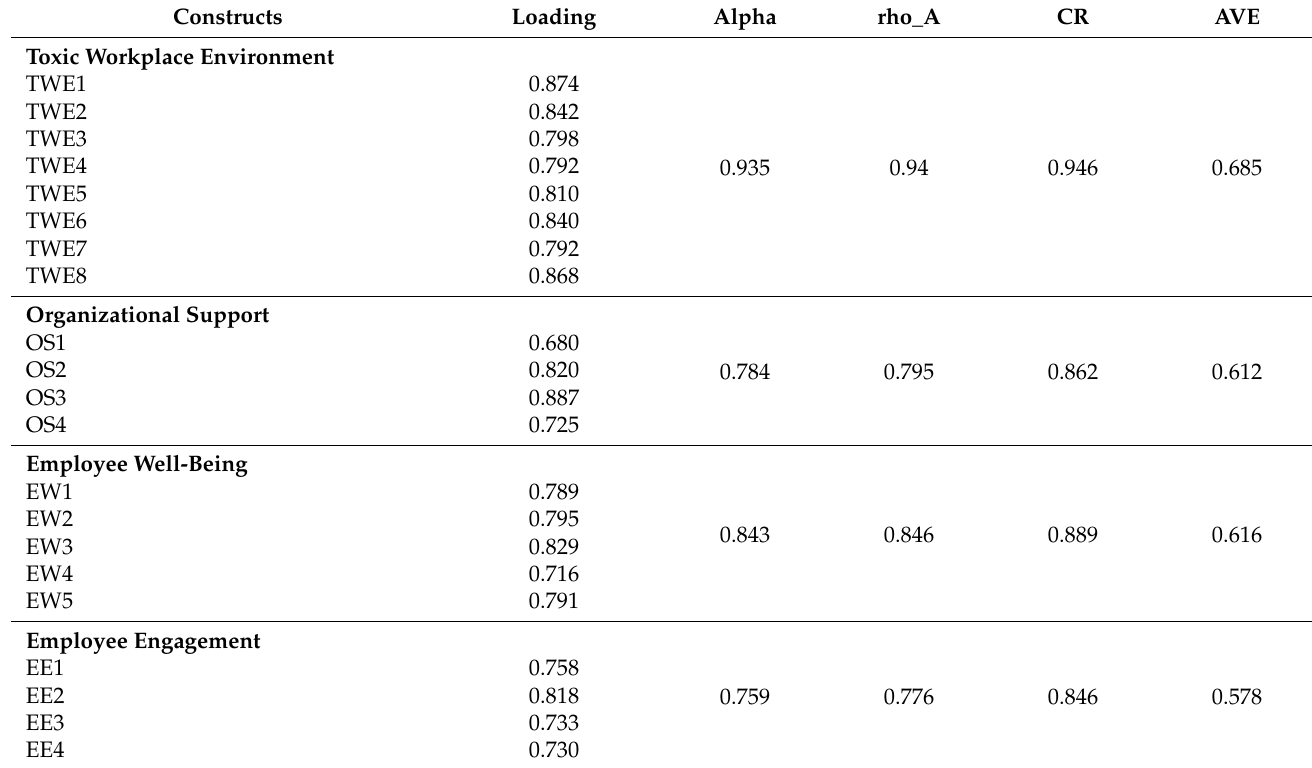
Table 2. Reliability and validity of the construct.